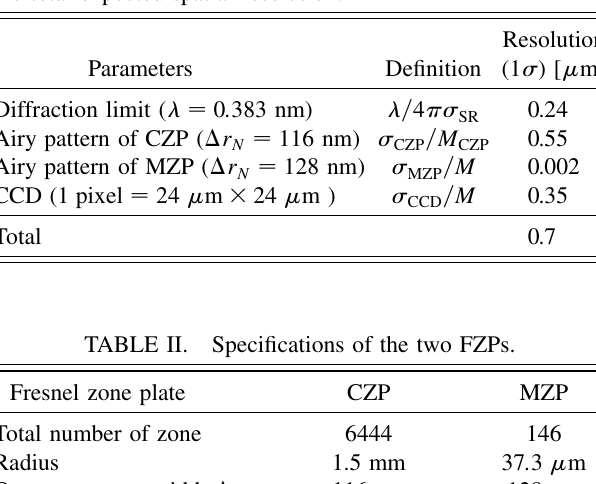
TABLE I. Expected spatial resolution of each parameter and the total expected spatial resolution.